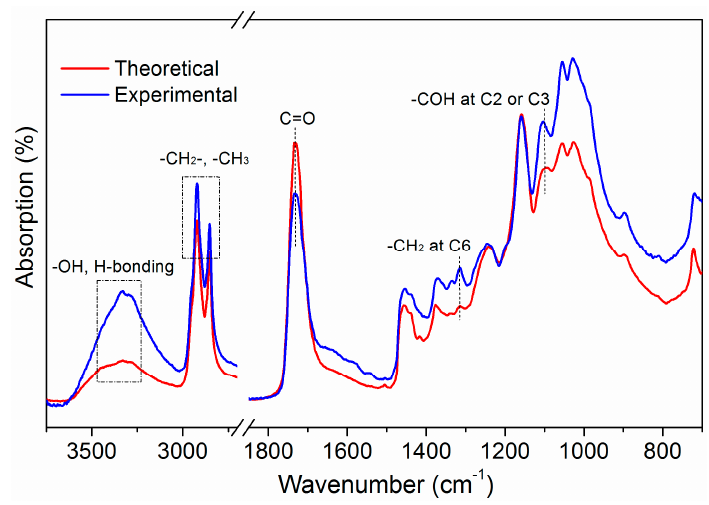
Figure 2. Comparison of experimental FTIR spectra of composite 30MCC with its theoretical curve calculated from pure MCC and AESO based on Lambert-Beer’s law.